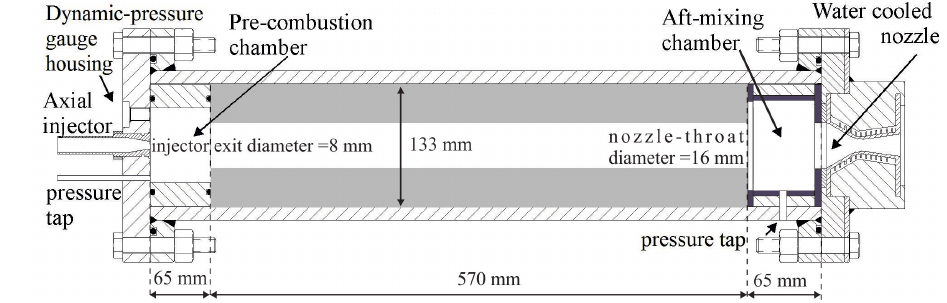
Figure 1. Lab-scale hybrid rocket engine